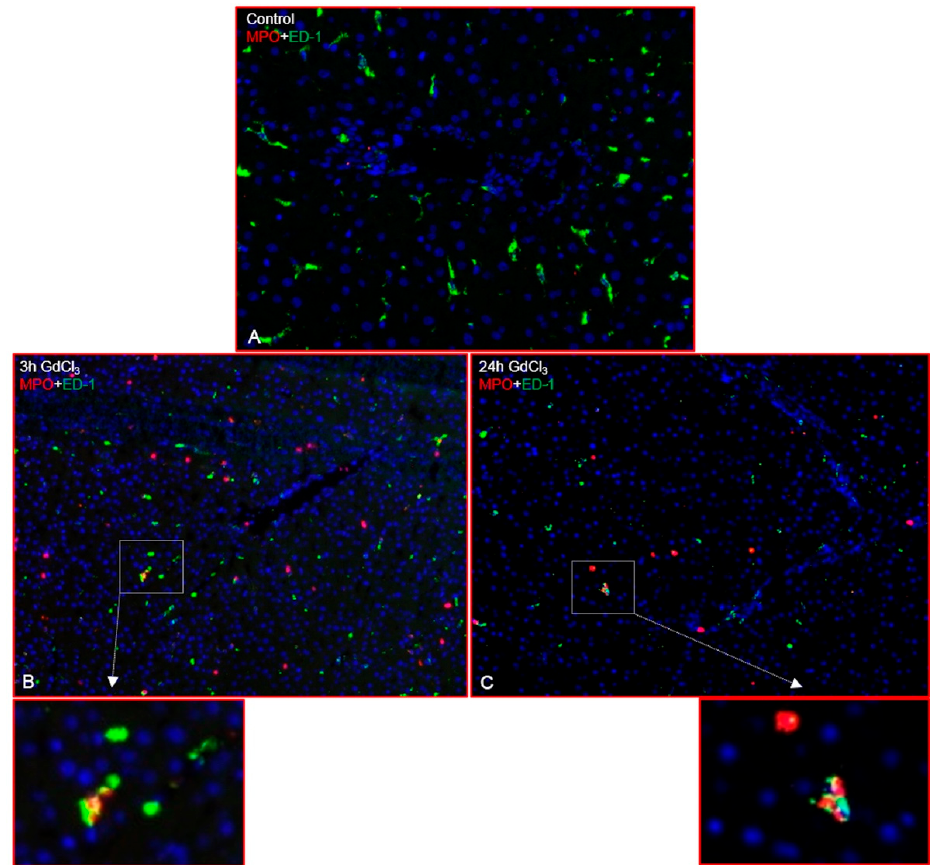
Figure 1. Double immunofluorescence staining of rat liver sections (GdCl 3 treatment) with antibodies directed against ED-1 (green) and MPO (red) followed by fluorescence immunodetection. Liver sections from different time points of study are shown: control ( A ); 3 h ( B ) and 24 h ( C ). Results shown are representative pictures of six animals and six slides per time point. (Original magnification 200×).